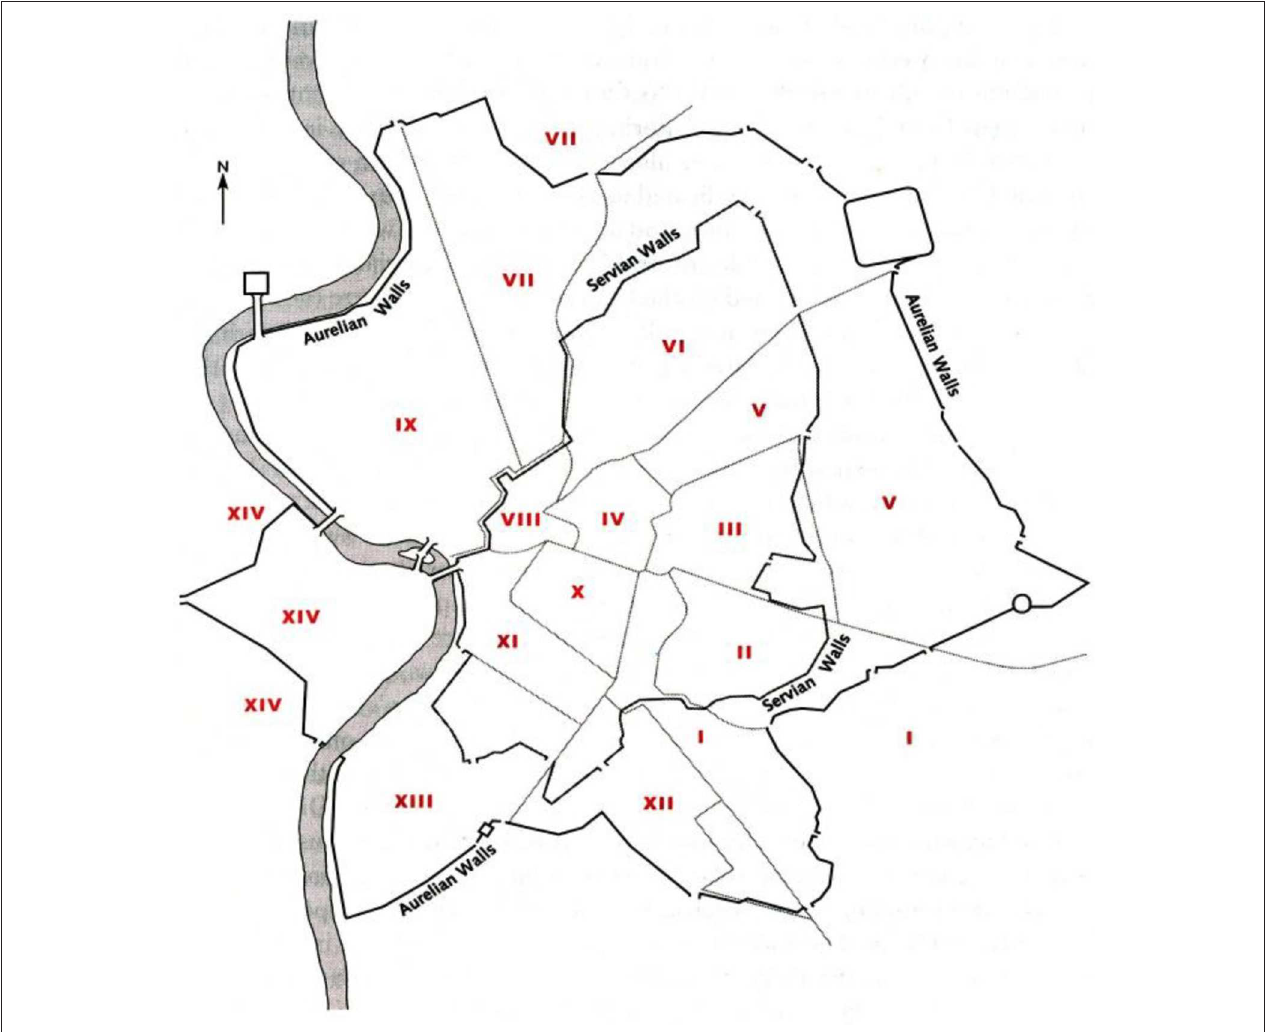
FIGURE 1 | The 14 Augustan regions as bound by the later Aurelian Wall. Regions II ( Caelimontium ) and V ( Esquiliae ) comprise the primary area of study (Coarelli, 2014, p. 7, Figure 2 in Rome and Environs: An Archaeological Guide © 2014 by the Regents of the University of California. Published by the University of California Press (Reproduced with